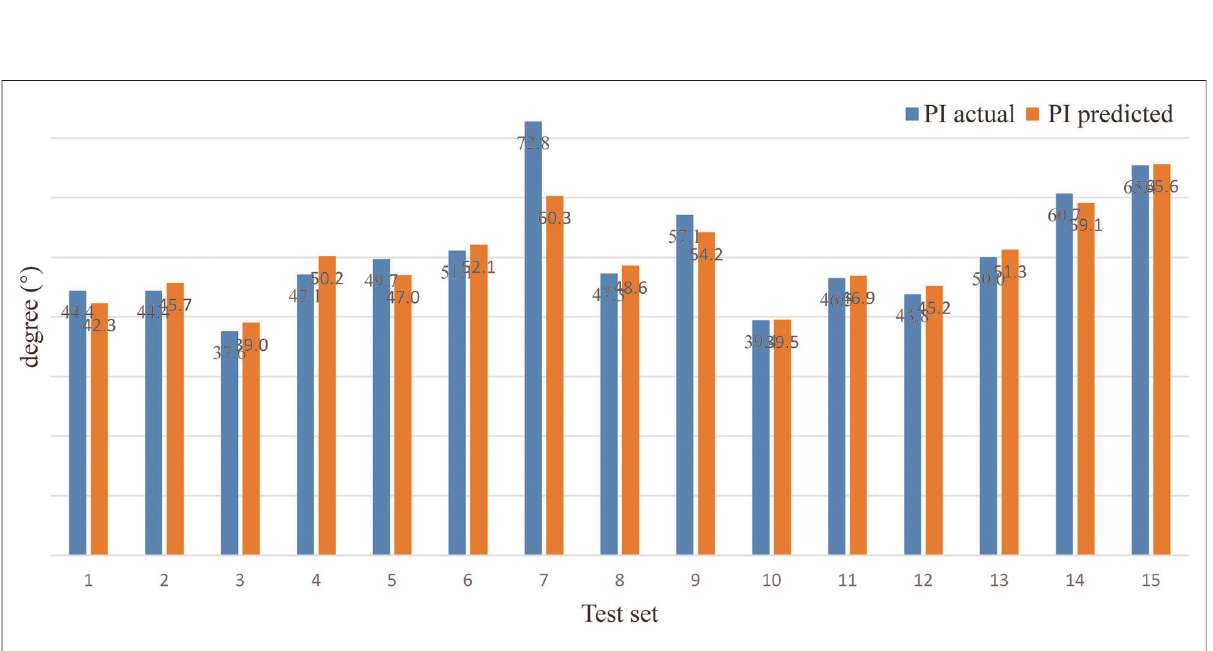
FIGURE 5 Comparison between the actual and the predicted values of sitting